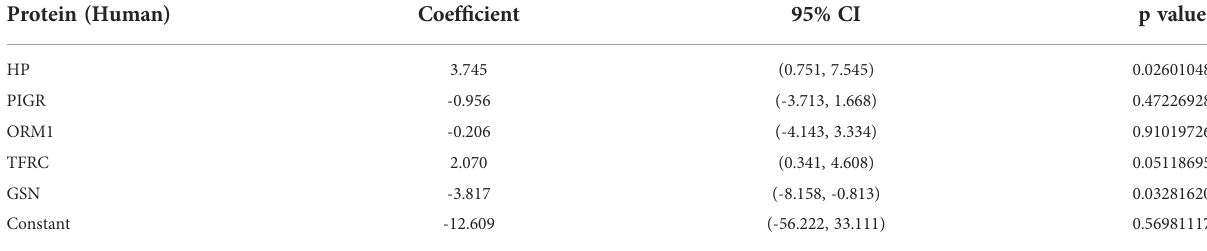
TABLE 3 The fi ve-protein logistic regression classi fi er for GAC diagnosis.